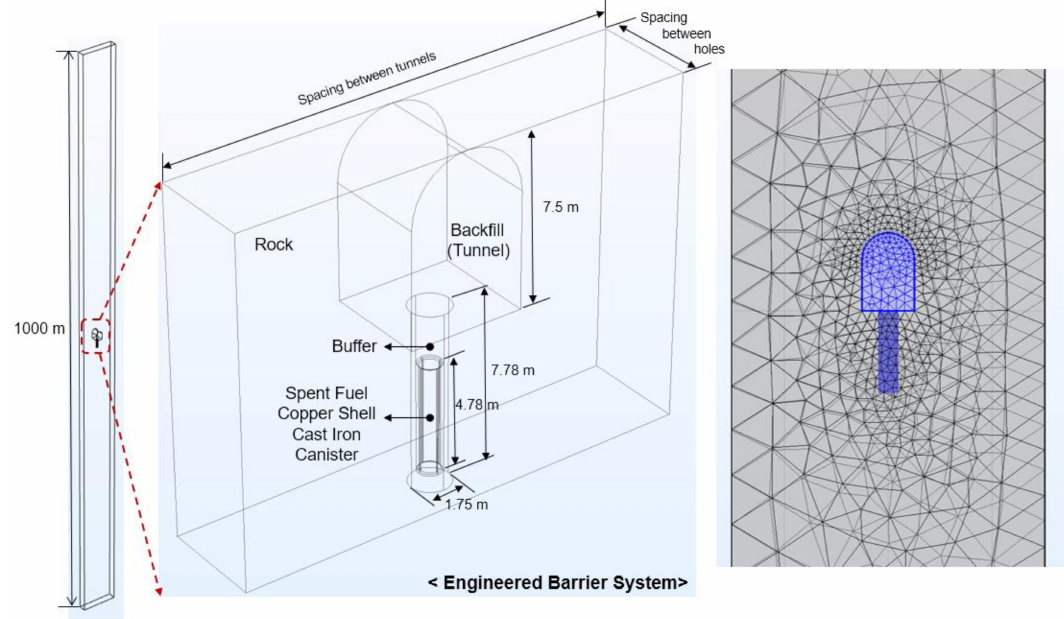
Figure 3. Geometry of 3D finite element model and generated